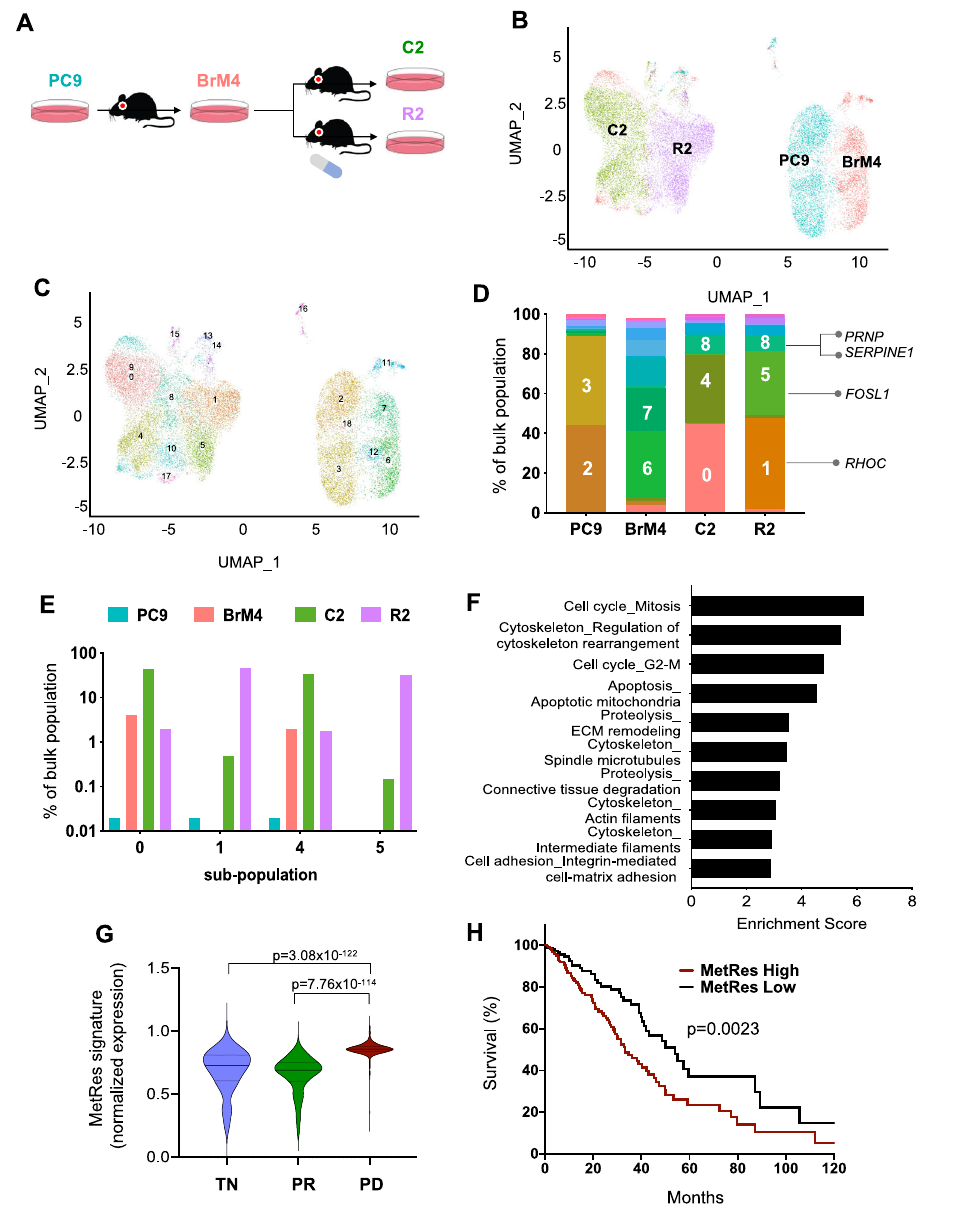
– log 10 ( P -value). G Differential mean expression of the dual Metastasis-Resistance (MetRes) signature is shown as a violin plot for single tumor cells collected from EGFR-mutant NSCLC patients ( N =20 patients) 24 . TN=treatment-naïve patients ( N =457 cells). PR=Patients with partial response after systemic therapy ( N =557 cells).PD=patientswithprogressivediseaseaftersystemictherapy( N =1088cells). P -value calculated by Welch t -test (two-sided). H Human LUADs from TCGA ( N =449) were classi fi ed as “ high ” or “ low ” based on whether expression of the MetRes signature was above or below the median, respectively. Kaplan – Meier curvesweregeneratedfortheincidenceofdeathof “ high ” vs. “ low ” groups. P -value calculated by log-rank test. The MetRes signature was generated for each sample (single cells in G ; bulk tumors in H ) by calculating the average expression of all MetRes genes identi fi ed in Supplementary Data